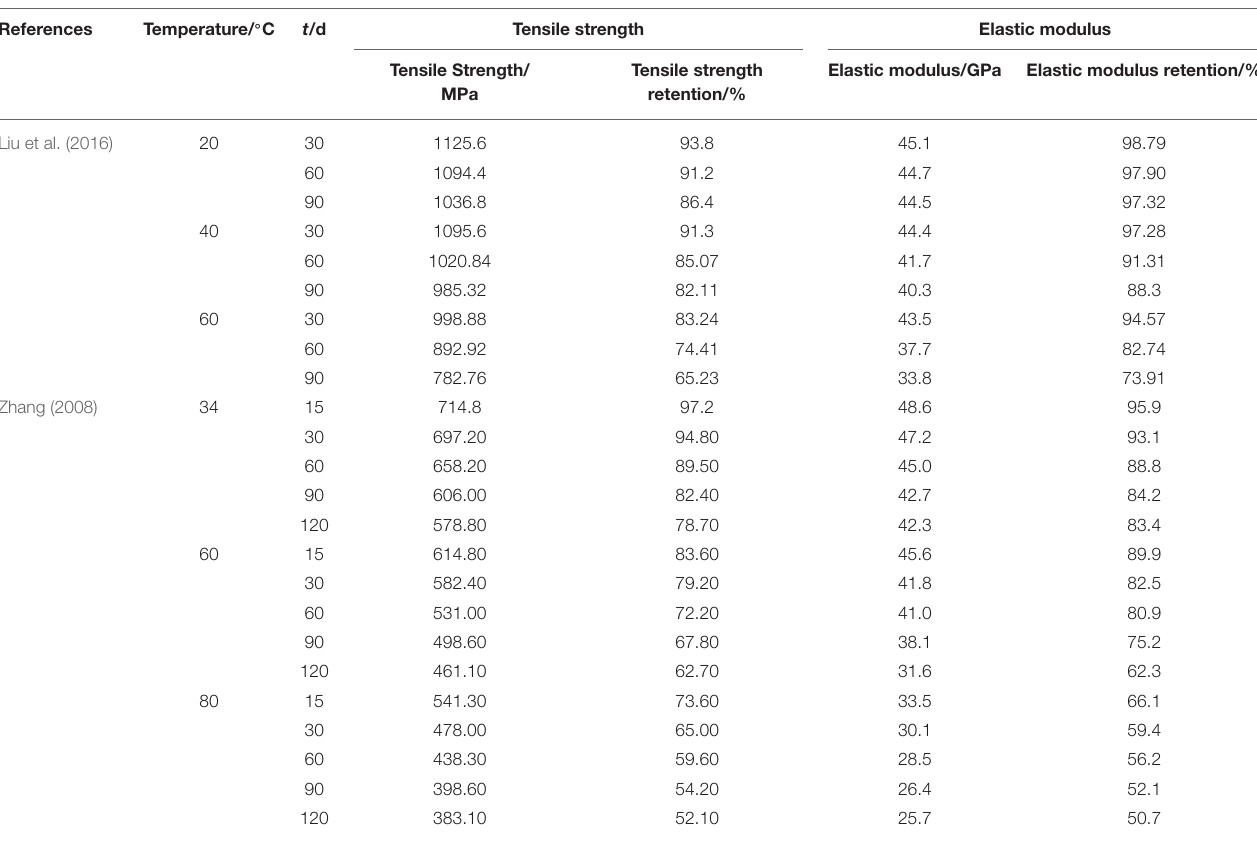
TABLE 1 | Test data of GFRP rebars exposed to alkaline